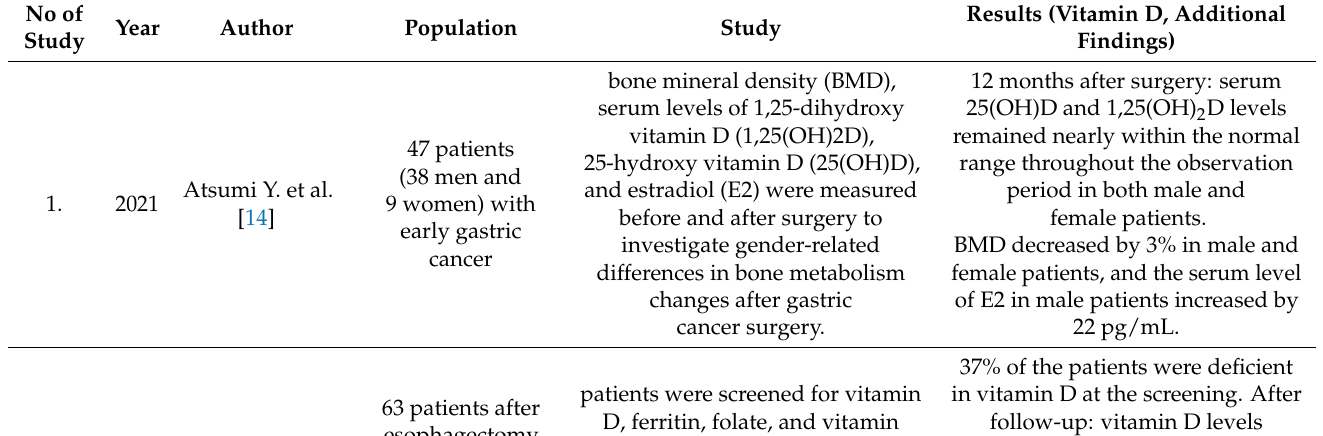
Table 1. Original studies and case reports on serum vitamin D concentration in patients with gastric cancer after